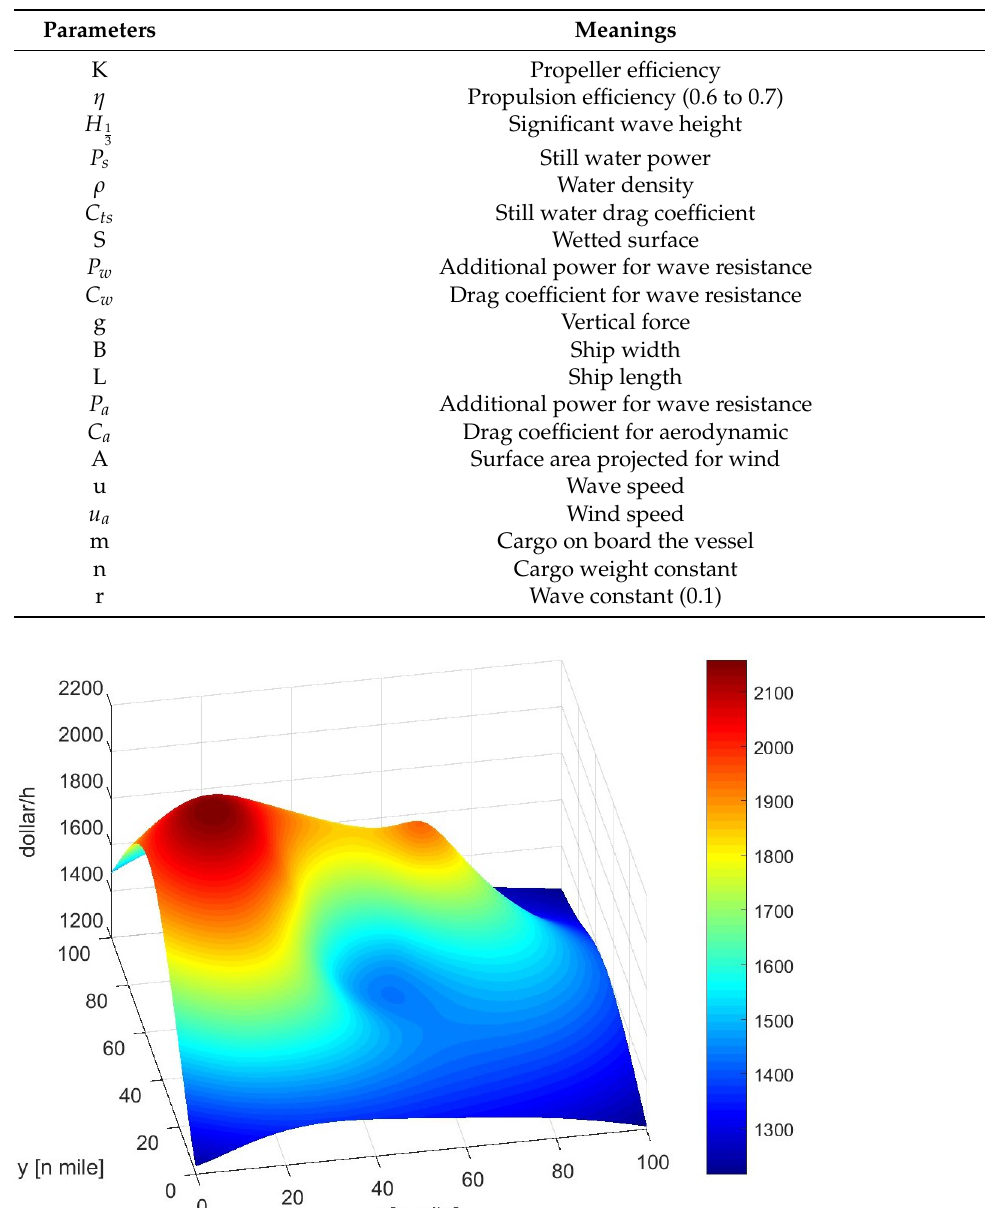
Table 1. Descriptions of parameters in equations.